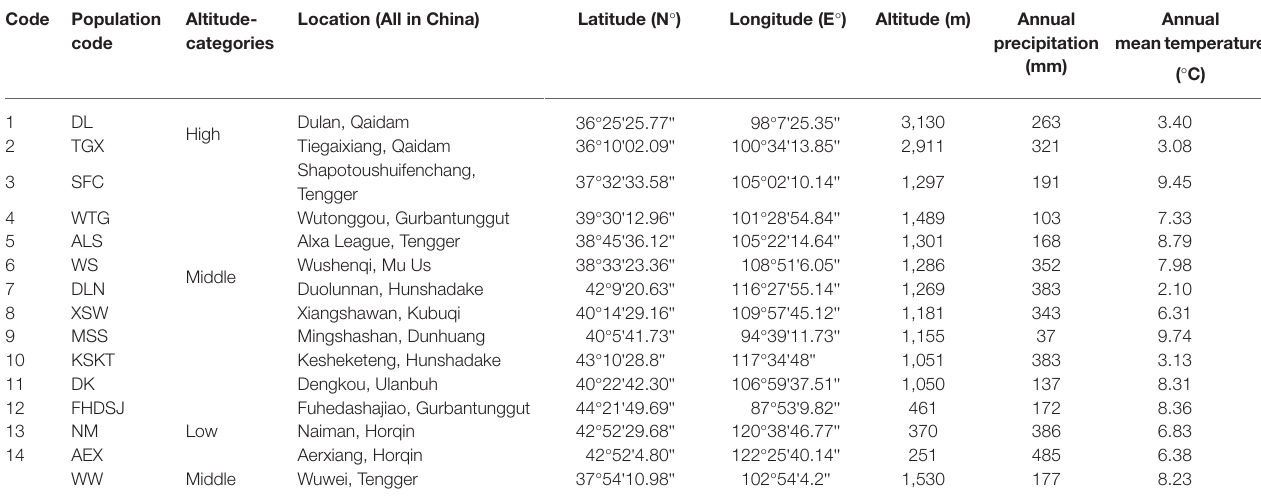
TABLE 1 | Details of the locality information of the sampled populations. Code Population Altitude- Location (All in code categories